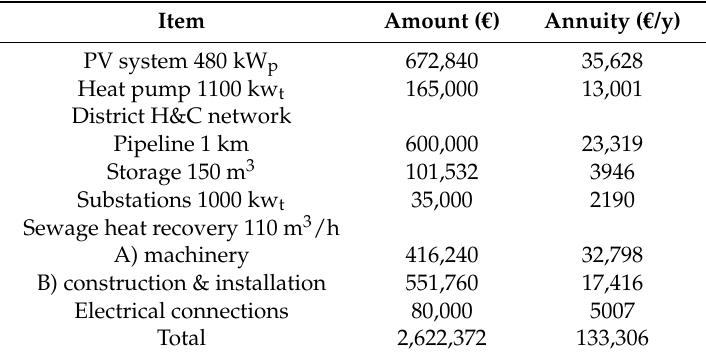
Table 3. CAPEX of the DHC system.